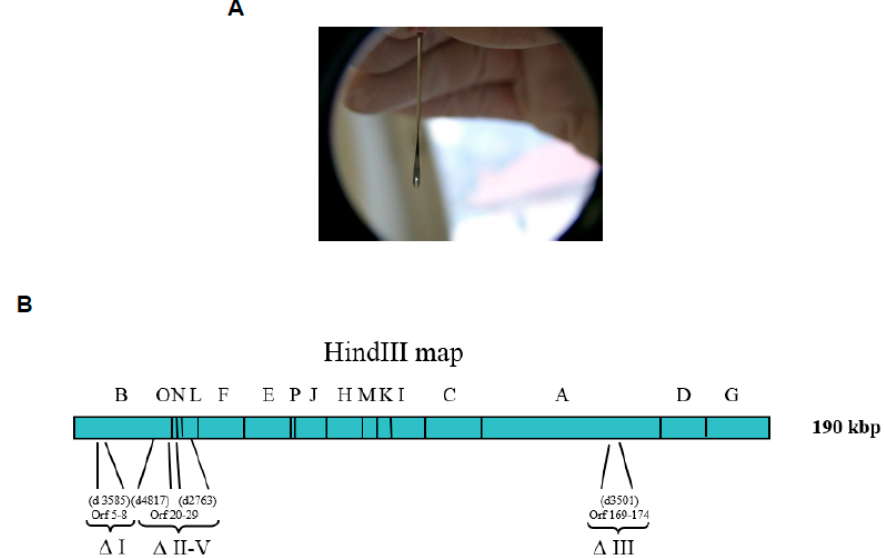
Figure 3. Bifurcated needle ( A ). Modified Vaccinia Lister (MVL) genome scheme with localization of deletions within the vaccinia virus (VACV) Lister-107 genome and the positions of the HindIII restriction fragments ( B ). The numbers in parentheses below the viral genome indicate the approximate locations of MVL deletions previously mapped in the Modified Vaccinia Ankara (MVA) strain relative to the Copenhagen strain (from left to right, according to the nomenclature of Antoine et al. [31]). The actual open reading frames (ORFs) that were deleted in the VACV Lister genome are identified beneath the indicated MVA deletions, and numbered according to Garcel et al. [29]. The roman numeral nomenclature shown under the deleted genomic regions described in Meyer et al. [32].